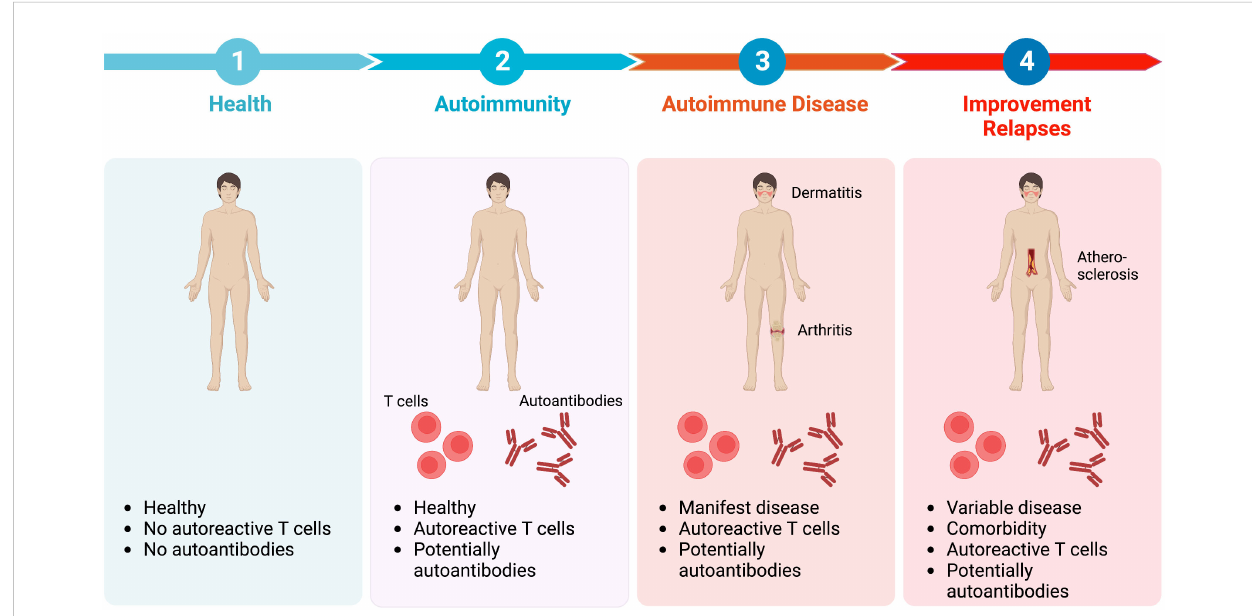
FIGURE 1 Transitional stages in the pathogenesis of autoimmune diseases. Regarding the transitional stages in the pathogenesis of autoimmune diseases, health (1) is de fi ned by no in fl ammatory symptoms and absence of autoreactive T cells and autoantibodies. However, in approximately 10% of healthy individuals autoantibodies can be detected. At this stage of autoimmunity (2) no clinical symptoms are apparent. Progression towards overt autoimmune disease (3) occurs in some, but not all individuals with autoimmunity. Autoimmune disease is characterised by clinical symptoms, such as dermatitis or arthritis, as well as the detection of autoreactive T cells and/or autoantibodies. Current treatment options improve disease. However, adverse drug events as well as comorbidity are encountered frequently (4). Besides, clinical relapses of disease ( fl ares) often occur, especially when treatment is tapered or withdrawn, because the underlying in fl ammatory sensitisation of tissue is sustained even during clinically silent phases (11). Image created with Biorender